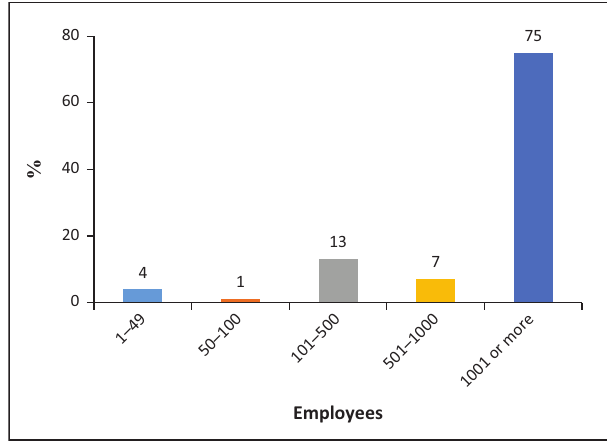
FIGURE 4: Number of employees in sampled orgaisations. FIGURE 3: Participants’ highest level of